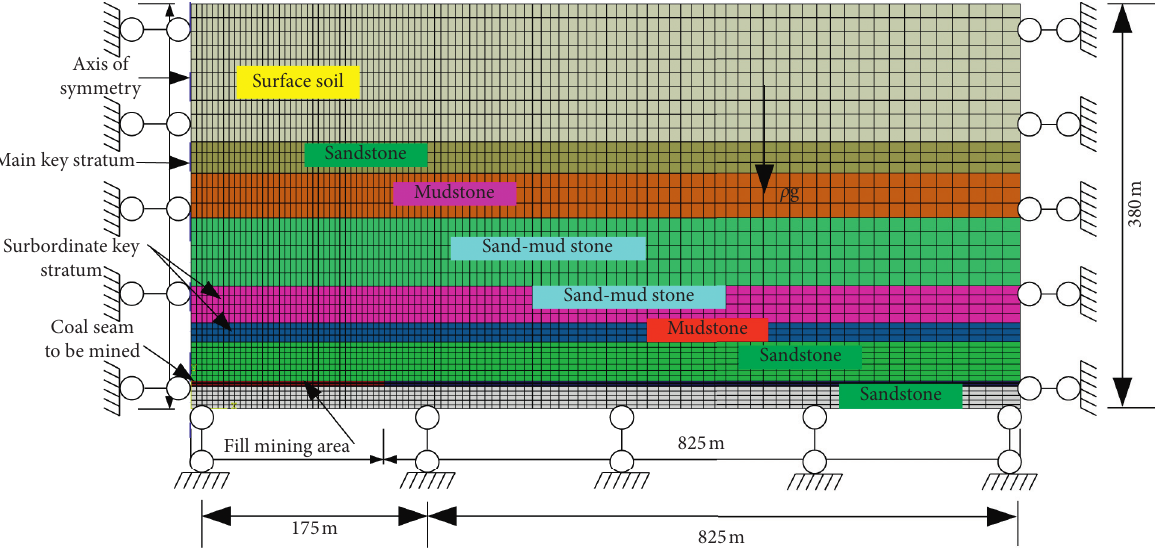
Figure 7: The numerical calculation model. Table 2: Physical and mechanical parameters of the model.